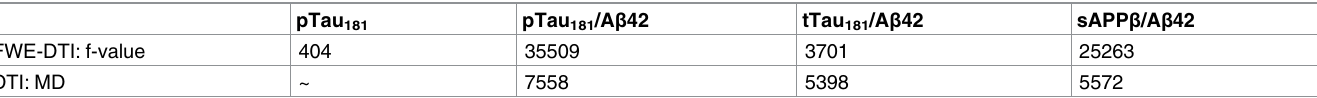
Table 8. The total extent of significant voxels (mm 3